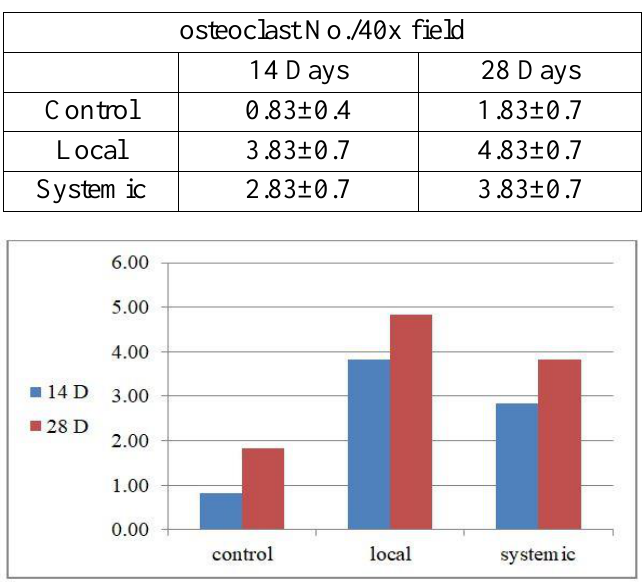
Fig. 5: The histogram of statistical analysis of osteoclasts. 3. Statistical analysis of the thickness of bone trabeculae: difference in the thickness of bone trabeculae between groups at different healing periods with systemically treated group over the control group as shown in table 4 and Fig.